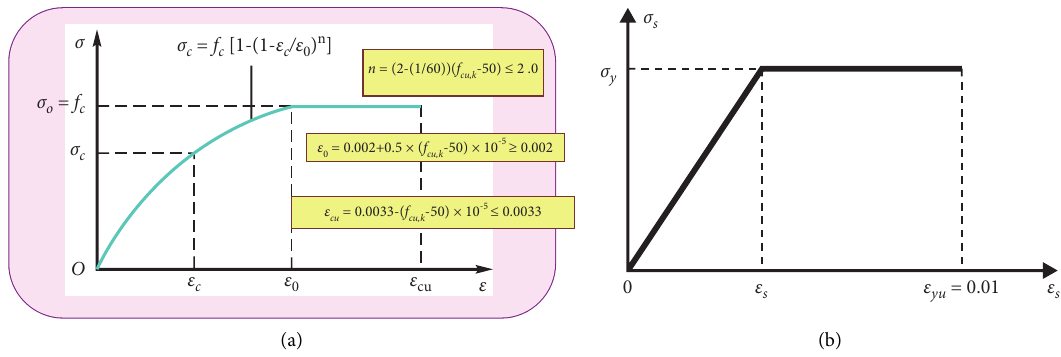
Figure 13: Stress-strain curve. (a) Stress-strain curve of concrete under compression. (b) Stress-strain curve of steel bar.